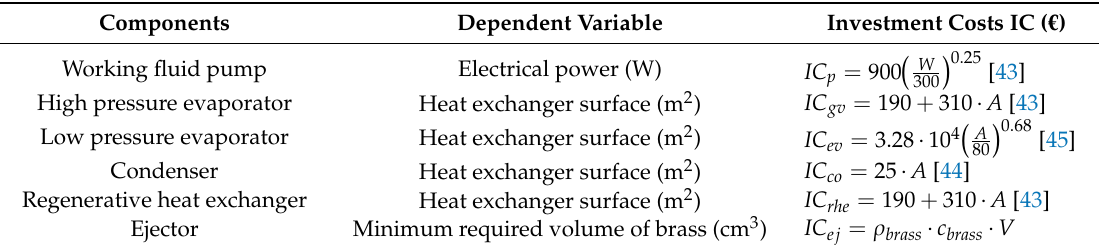
Table 4. Cost functions for each